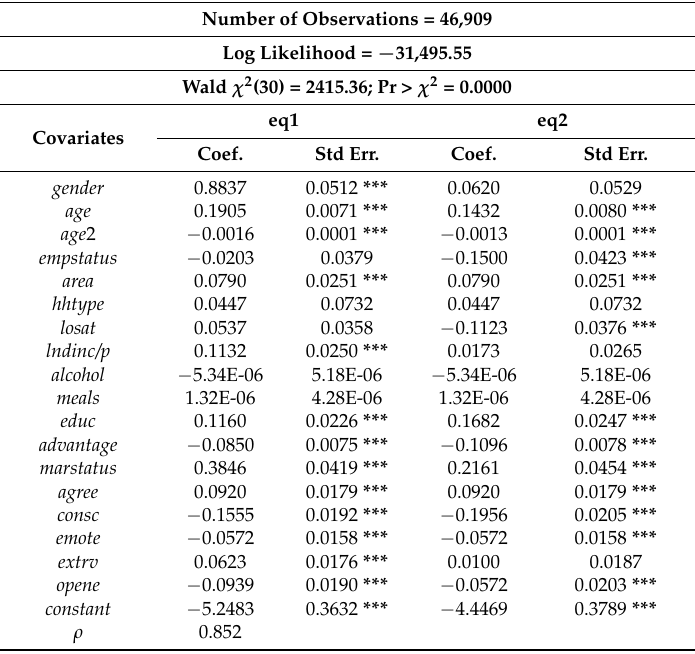
Table 5. Estimates for the restricted generalized order